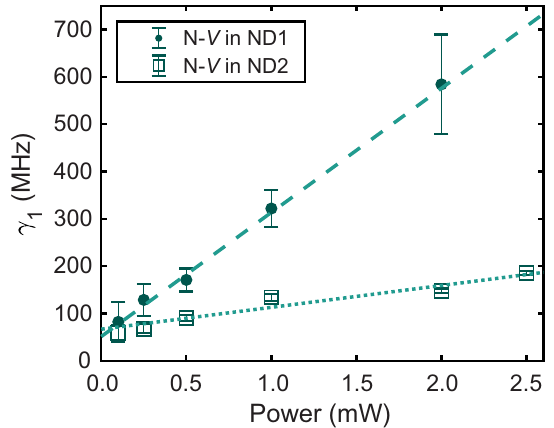
FIG. 9. Antibunching rate of N- V centers in nanodiamonds. The antibunching rate (denoted by circles and squares) is mea- sured as a function of excitation power. The lines (dashed and dotted) are fits to the rates. The error bars represent one standard